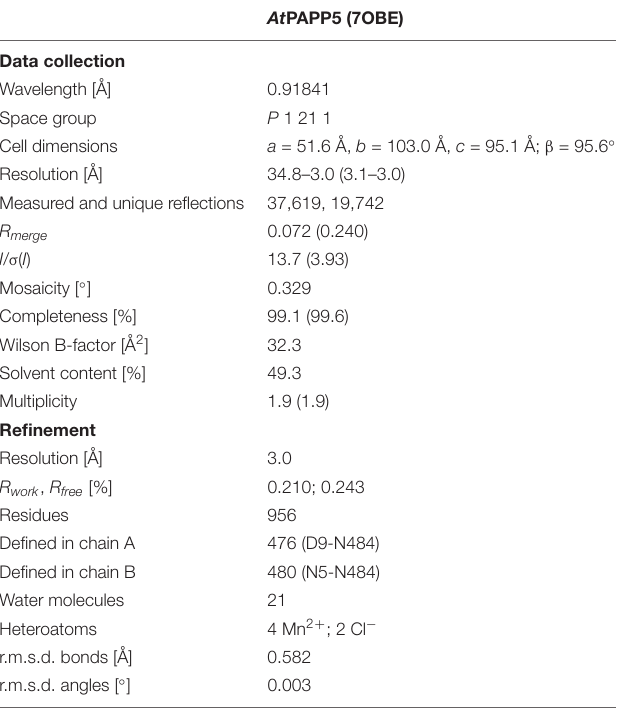
TABLE 1 | Statistics for data collection and refinement of At